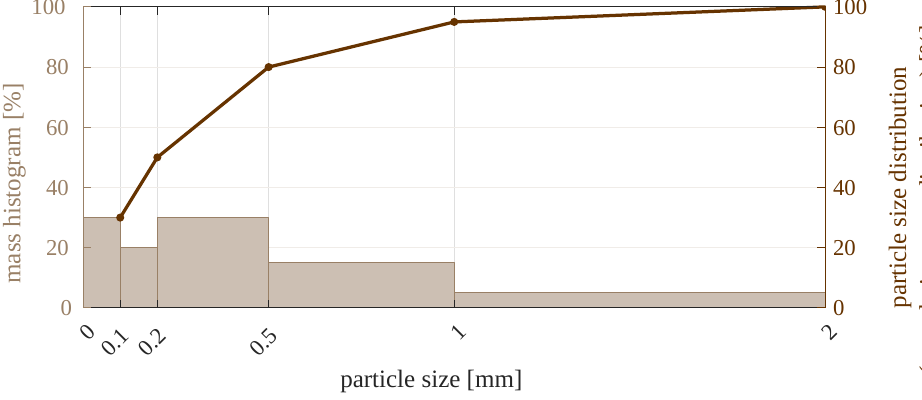
Figure 3. Composition of the mixed-size material used in the experiments.